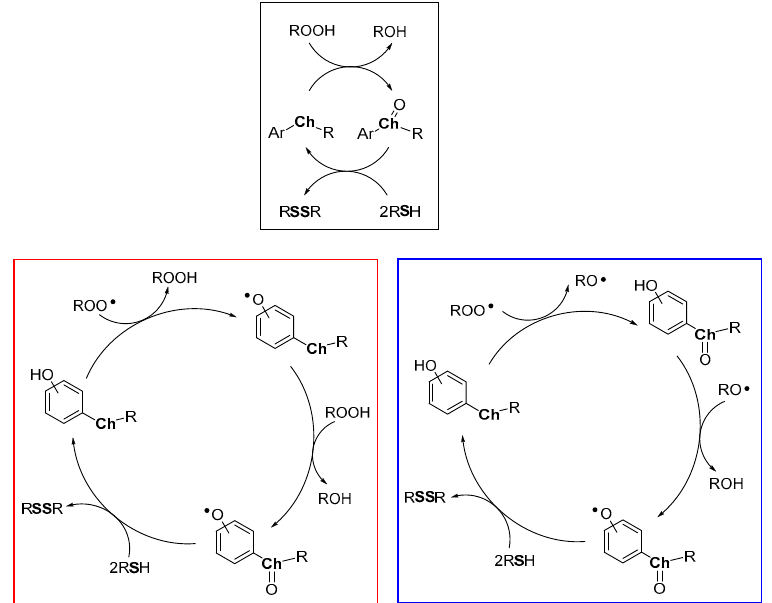
Figure 12. Heavy chalcogens (Se, Te) possible catalytic cycles (black frame, red frame and blue frame) in the presence of hydroperoxides or peroxyl radicals as oxidants and a sacrificial thiol as co- antioxidant.